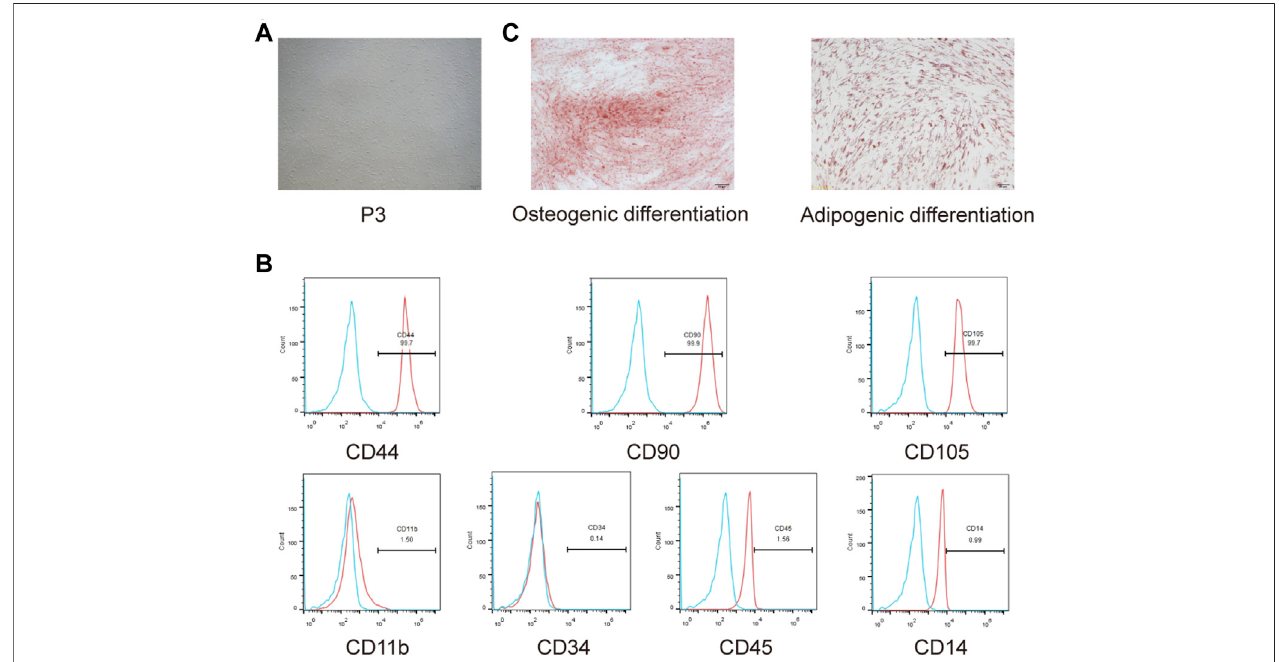
FIGURE 3 | Isolation and identi fi cation of SHED. (A) Morphology observation of isolated cells from exfoliated deciduous teeth. (B) CD44, CD90, CD105, CD11b, CD34, CD45, and CD14 expressions were measured using fl ow cytometry. (C) Osteogenic andadipogenic differentiation abilities of isolated cells were assessed.